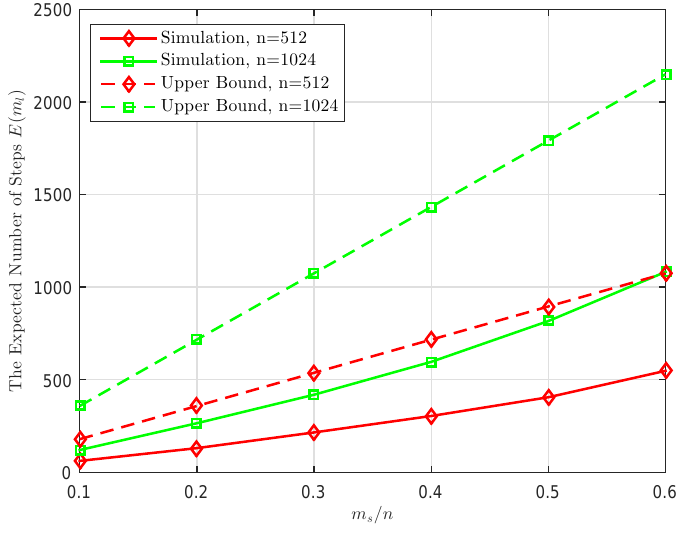
Figure 8. The expected number of steps m l taken by mobile collector to visit m s distinct sensor